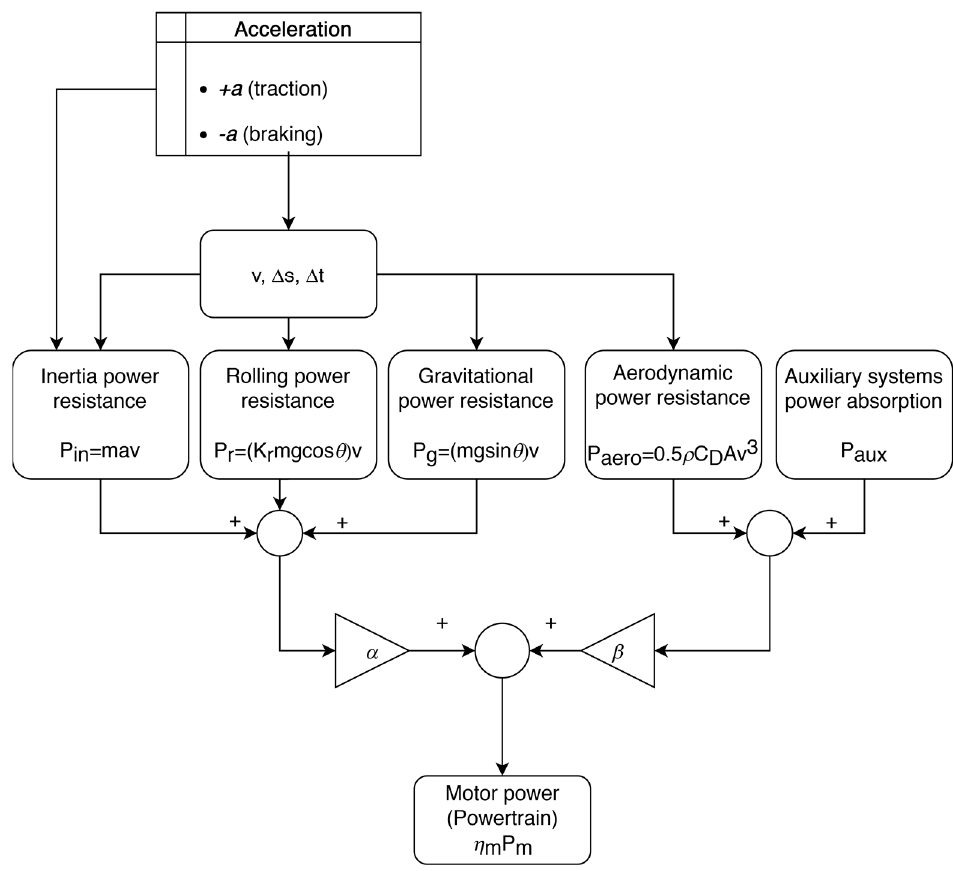
Figure 5. VRP vehicle model.